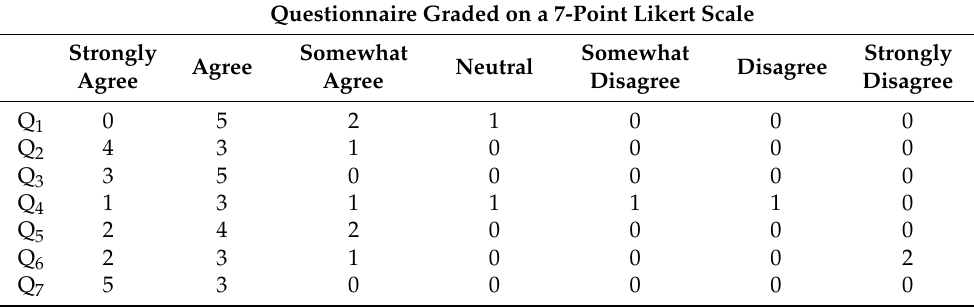
Table 2. Agreement level provided by medical staff using 7